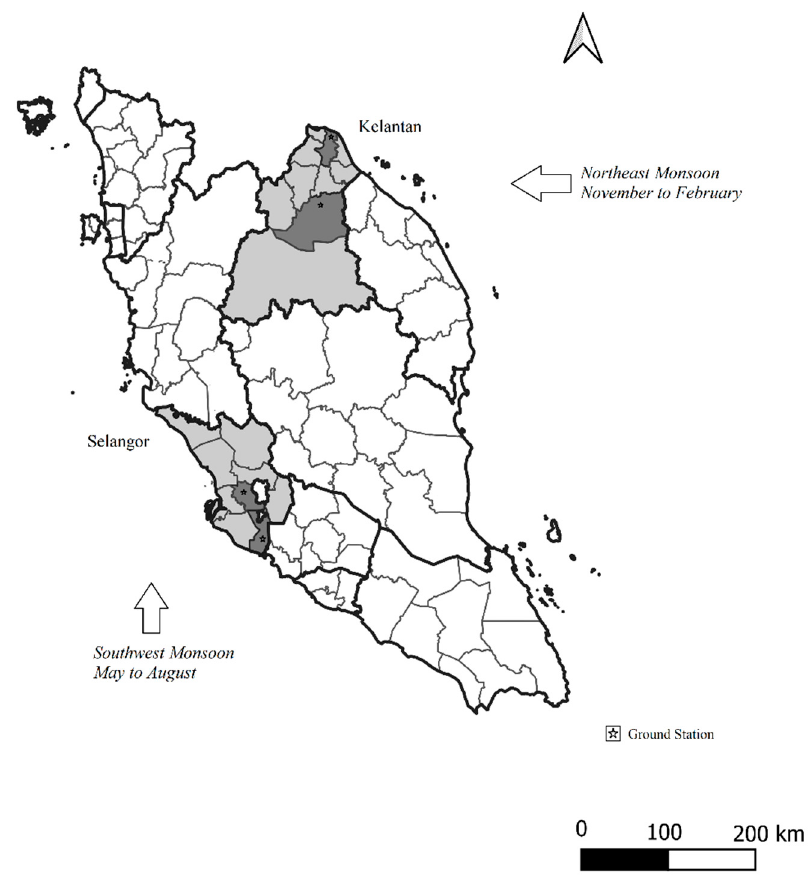
Figure 2. Rainfall, Temperature and Wind speed data collected from Ground based stations ( n = 4) in Peninsular Malaysia.